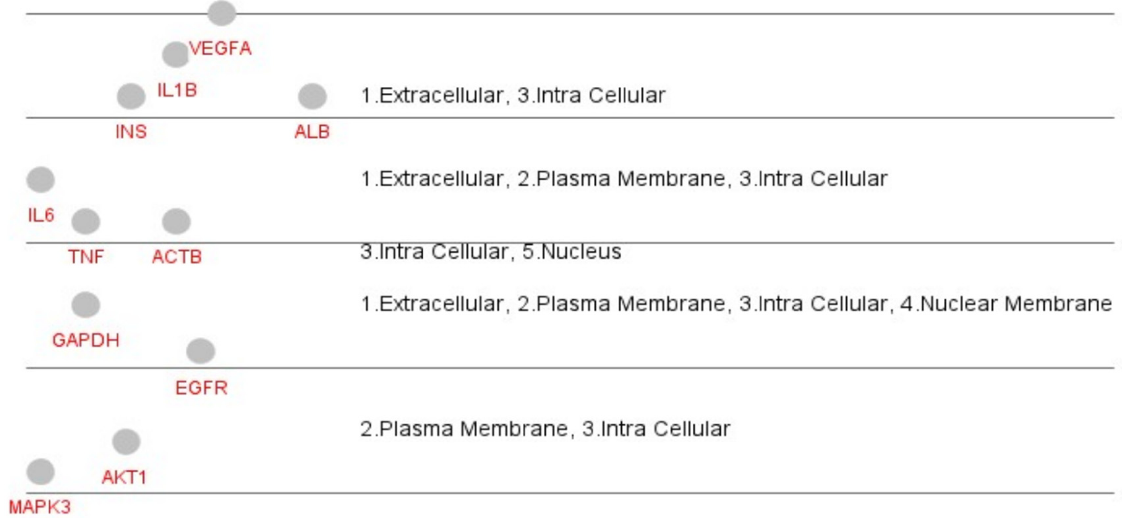
Figure 6. The cellular location of the potential marker based on CluePedia analysis.